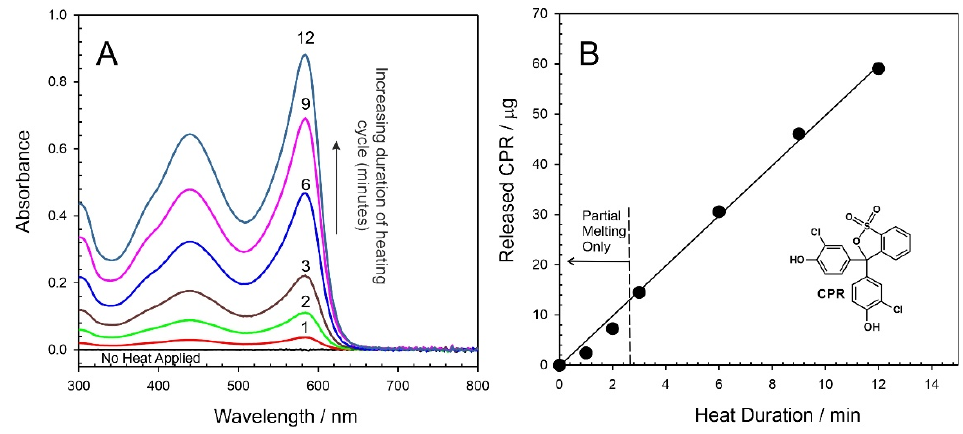
Figure 8. ( A ) UV/Vis spectra detailing the release of chlorophenol red (CPR) from the wax composite into pH 6 buffer as a function of heat duration. ( B ) Estimation of the amount of CPR released during each cycle.